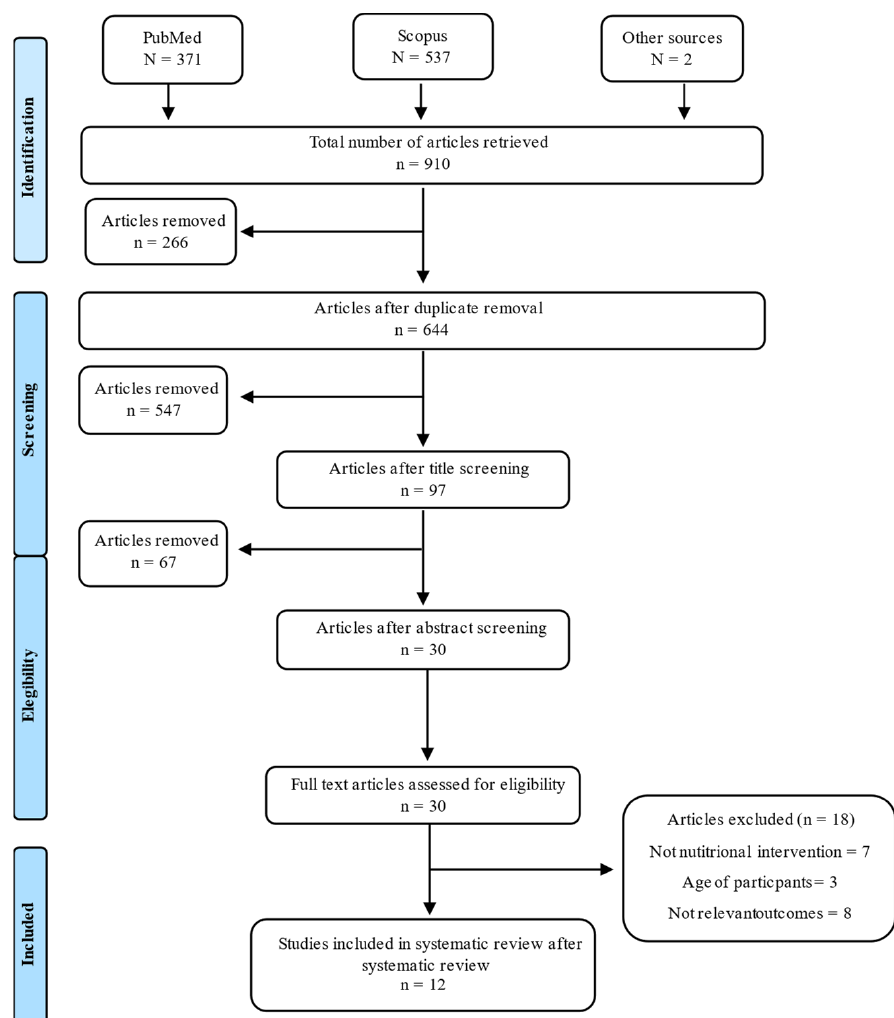
Figure 1. Flow diagram of identification, screening and selection process for included articles.